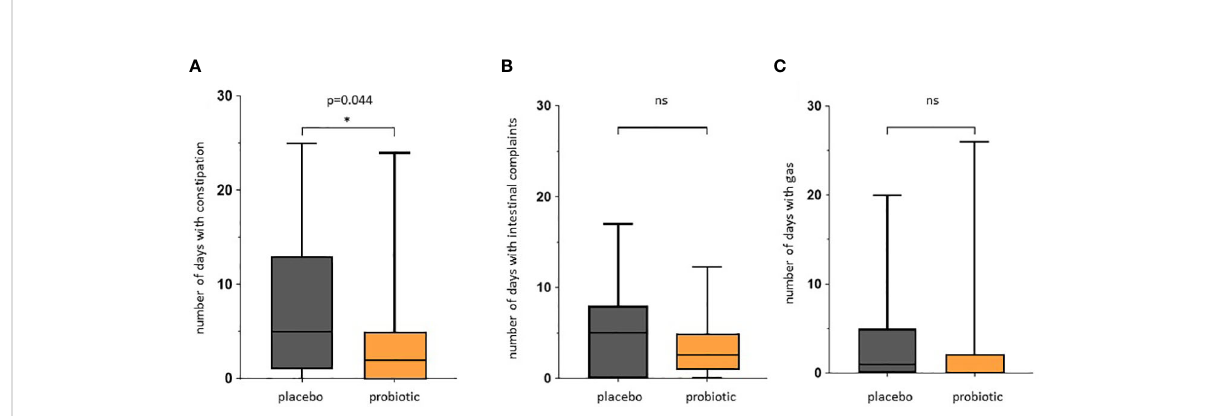
FIGURE 5 Questionnaire for gastrointestinal symptoms after colonoscopy. Days spent with gastrointestinal symptoms for placebo and probiotic group. (A) Number of days self-reported with constipation according to Bristol stool scale. (B) Number of days self-reported with intestinal complaints. (C) Number of days self-reported with bloating. The intestinal complaints include all recorded adverse events for all days of observation. ns, not statistically signi fi cant. * p value<0.05.